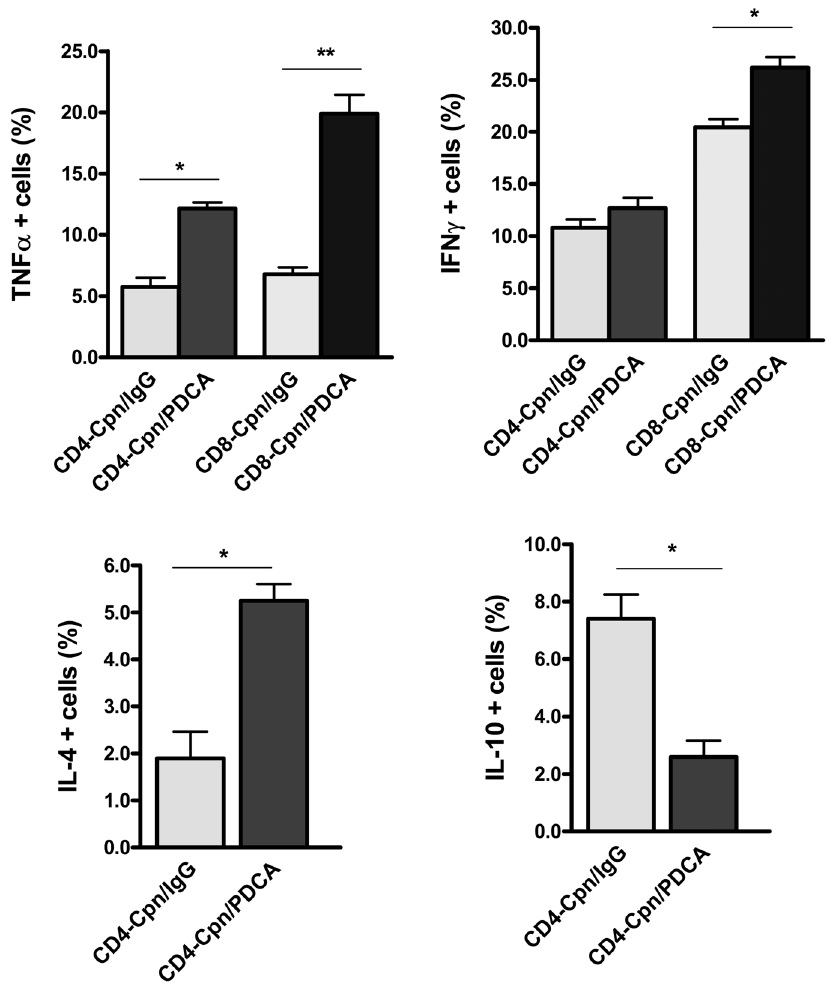
Figure 4. T cell specific cytokine pattern in the lungs of pDC depleted mice following Cpn infection. Following Cpn infection (day 9), the cytokine pattern of CD8 and CD4 T cells in the lungs of pDC depleted and control mice was analysed by intracellular cytokine staining. Graphs show the summary data for TNF a ( A ), and IFN c ( B ) production by CD8 and CD4 T cells and IL-4 ( C ) and IL-10 ( D ) production by CD4 T cells. Data are expressed as mean 6 SD. Three independent experiments with three mice in each group were performed and one representative experiment is shown. *, p , 0.05, **, p , 0.01.